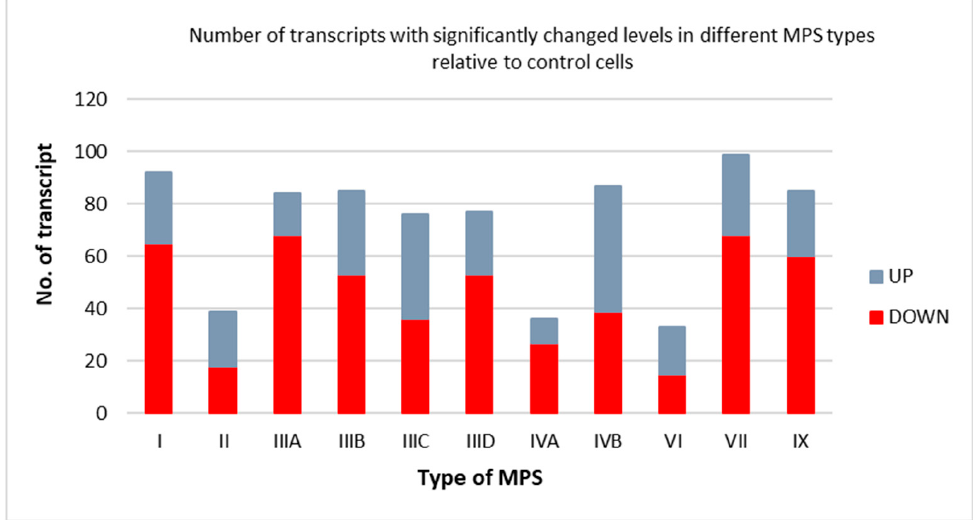
Figure 1. Number of transcripts coding for proteins involved in gene expression (GO:0010467) with changed levels (at FDR < 0.1; p < 0.1) in different types of MPS relative to control cells (HDFa). Up-regulation (UP) and down-regulation (DOWN) in MPS relative to HDFa are marked.